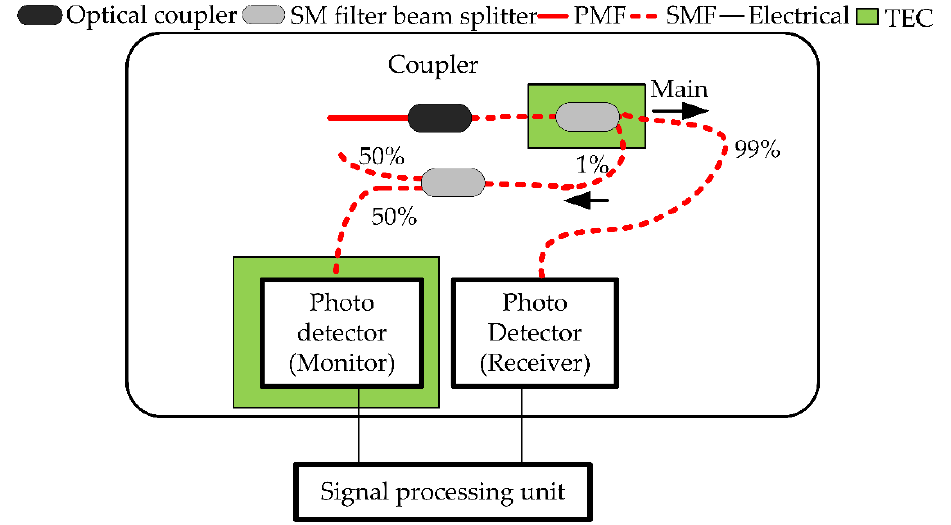
Figure 6. Same experimental setup as Figure 4, but another TEC was added to the monitoring photodetector.